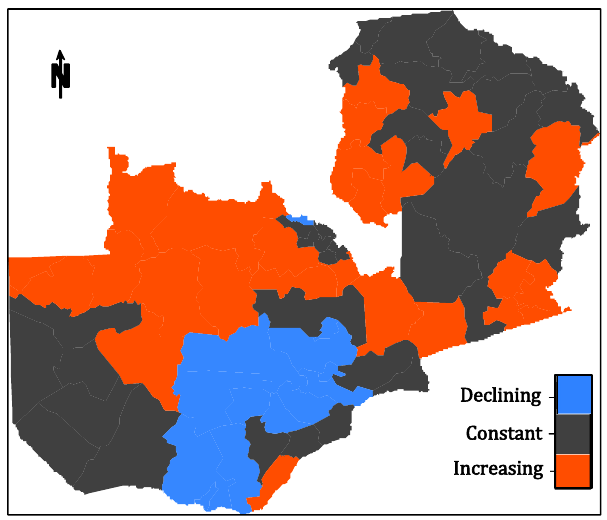
Figure 1. Malaria trends in Zambia districts between 2000 and 2016. Classifications are based on the maximum a posteriori probability for that trend.All results in the model had the highest posterior probabilities between 0.75 and 1, which is the highest certainty in